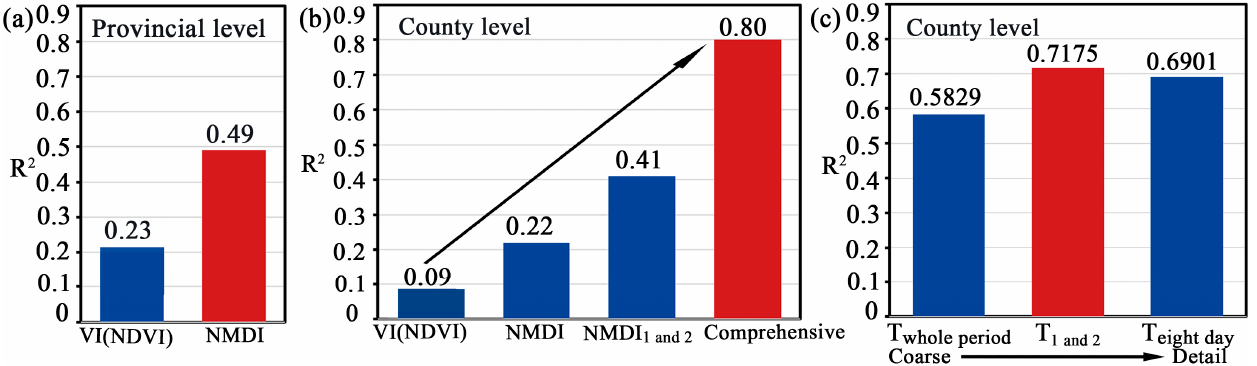
Figure 6. Yield estimations at the ( a ) provincial level and ( b ) county level; ( c ) effect of temporal aggregation data on yield estimation. Note: NMDI represents the value of the whole-growth period, and 1 and 2 in “NMDI 1 and 2 ” and “T 1 and 2 ” represent the values of both the vegetative and reproductive growth periods.